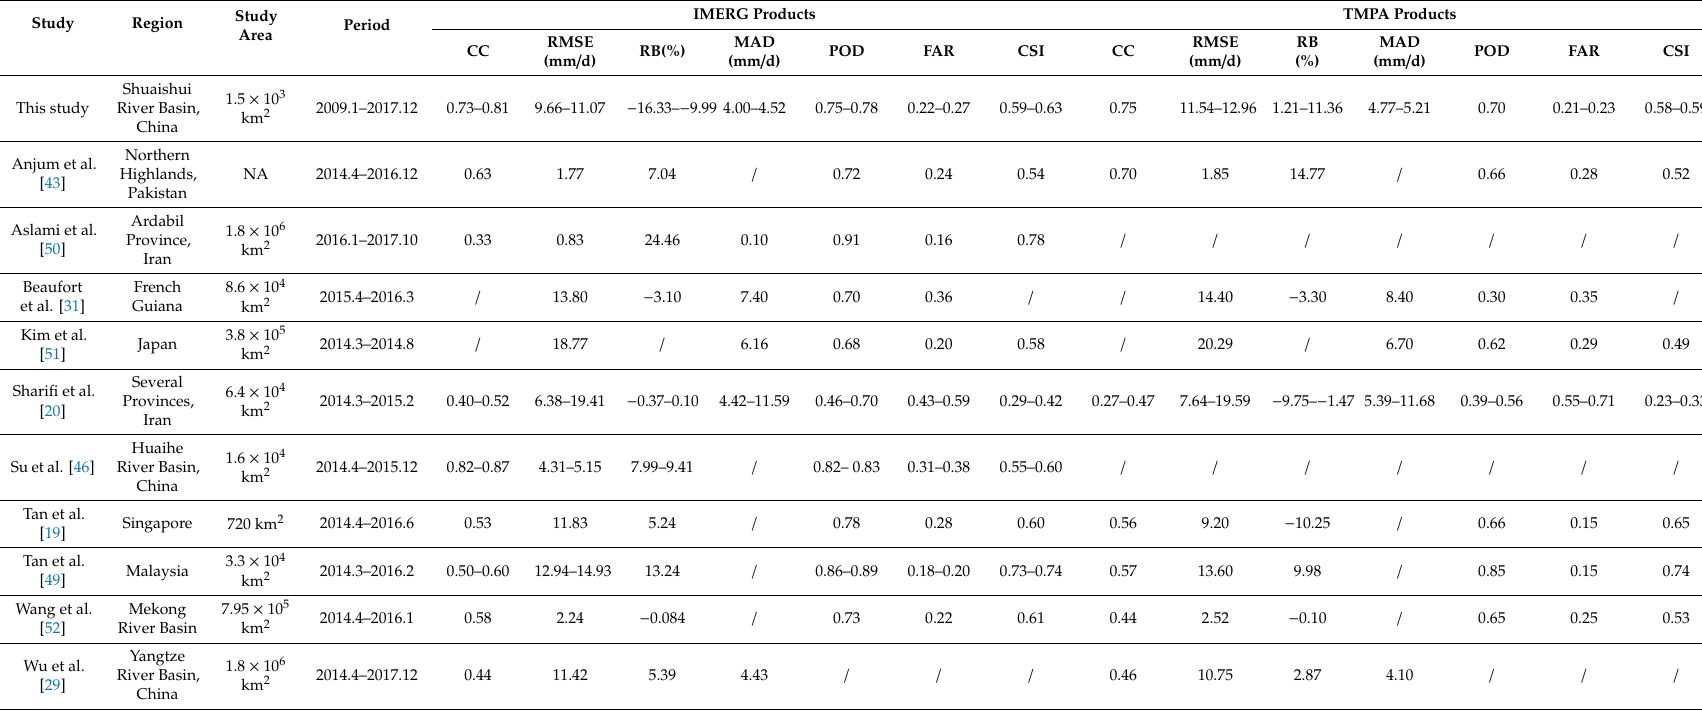
Table 5. Comparison of the evaluation metrics of the SPPs at daily scale between this study and previous